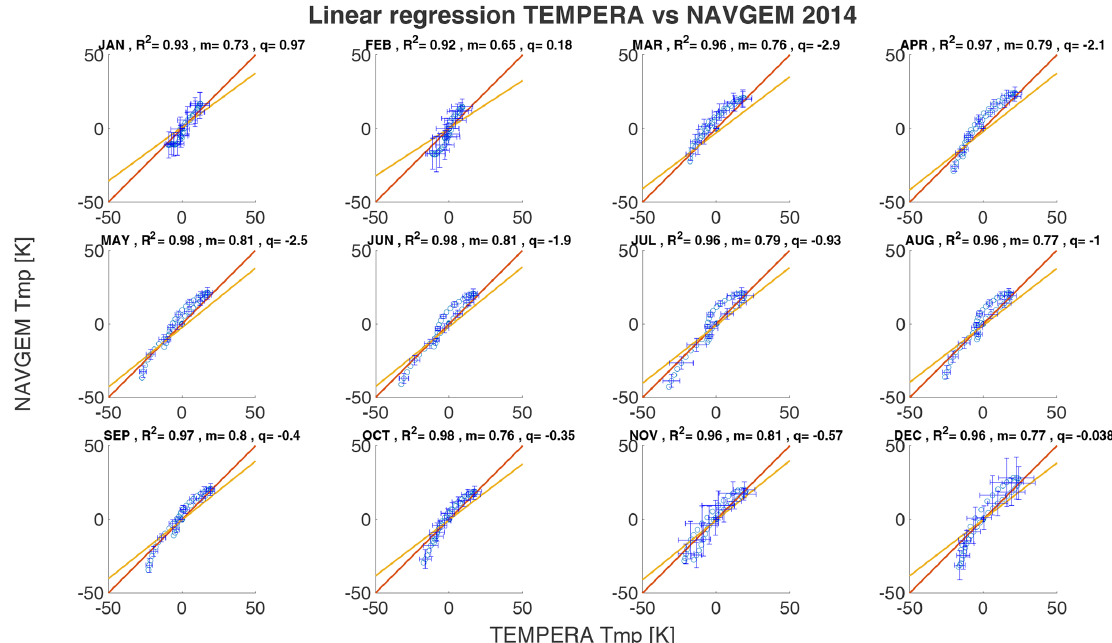
Figure A2. Linear regression of TEMPERA against NAVGEM temperatures for the year 2014.